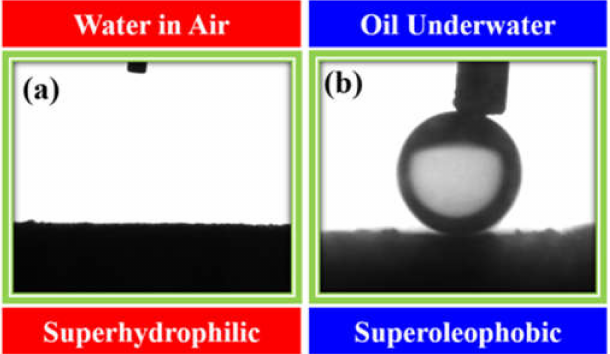
Figure 12. ( a ) Water contact angle in air and ( b ) underwater oil contact angle of the M-100